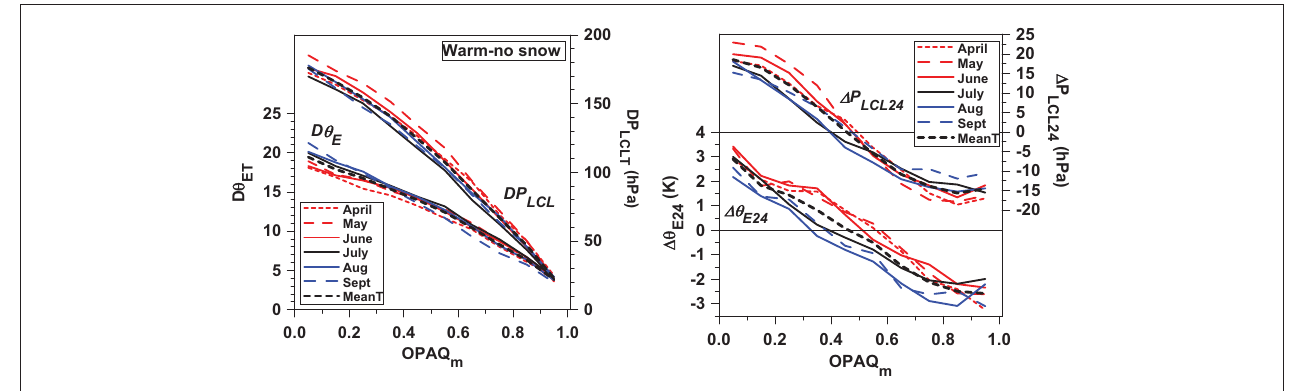
FIGURE 17 | OPAQ m dependence of D θ ET and DP LCLT (left) and (right) 24-h imbalances of 1 θ E24 and 1 P LCL24 for April to September.